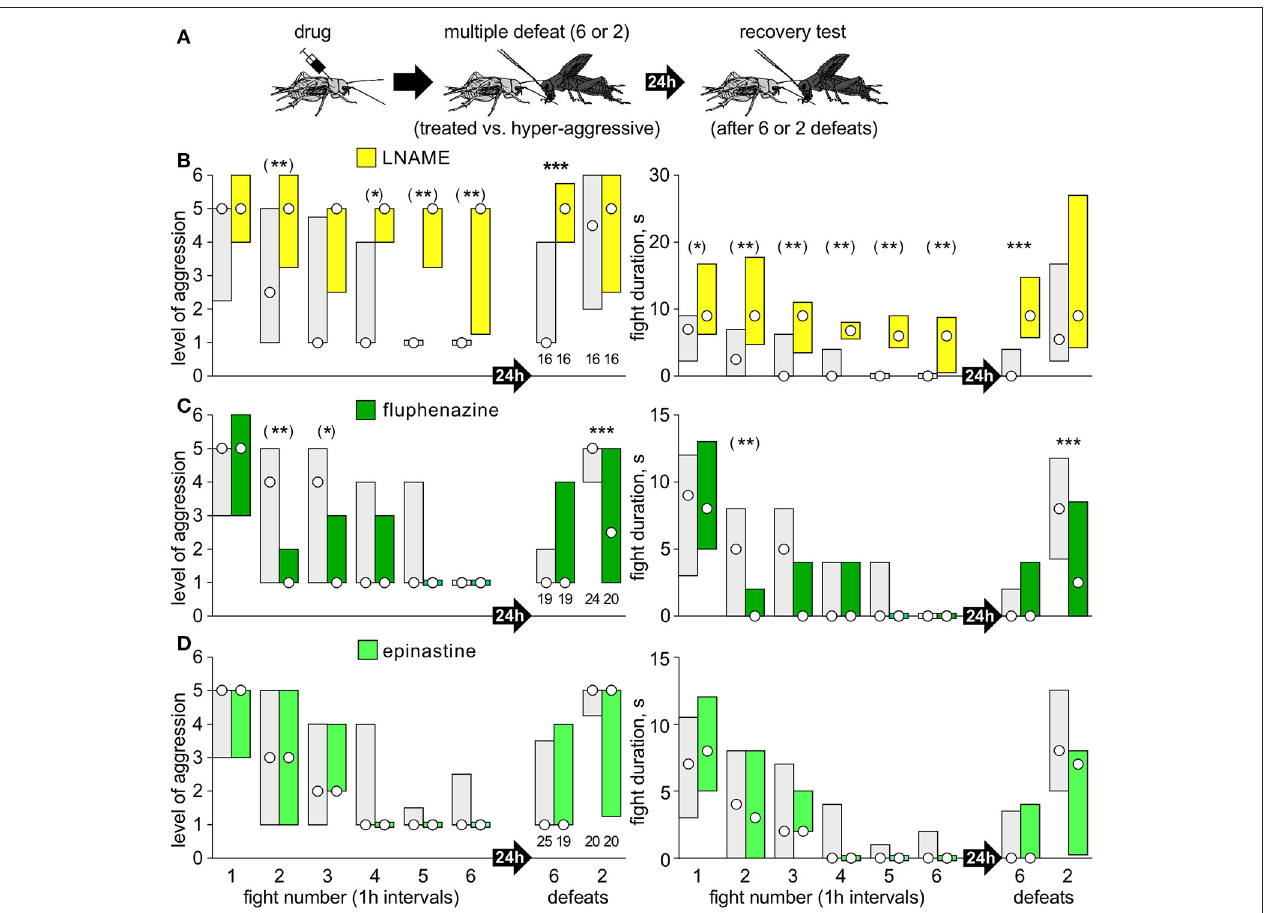
FIGURE 3 | Test for effects of NO, DA, and OA. (A) Procedure, as for Figure 2 , but with different drugs: (B) LNAME (yellow bars); (C) fluphenazine (dark green bars); (D) epinastine (light green bars). Controls received vehicle or DNAME to control for LNAME (gray bars). Asterisks indicate significant differences between test and control groups as given by Mann-Whitney U-tests for the tests after 24h after defeat: *, **, ***: p < 0.05, 0.01, 0.001. For the six repeated defeats, we applied the Bonferroni corrections for multiple comparisons: (*), (**), (***): p < 0.01, 0.002, 0.0002).